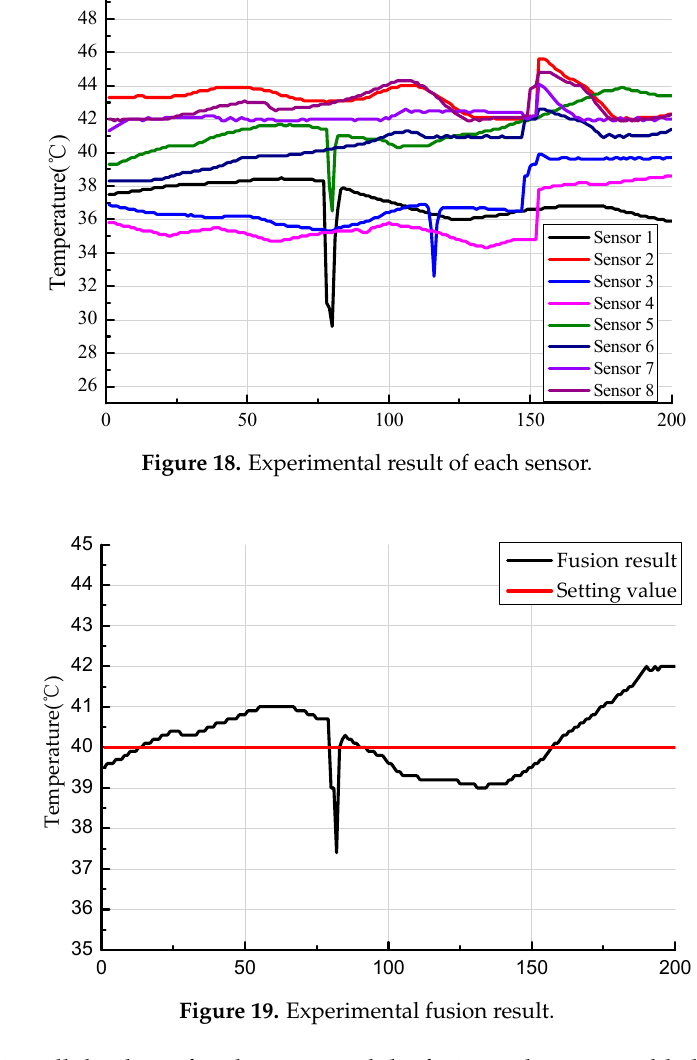
Figure 17. Processing flow of the experimental data.